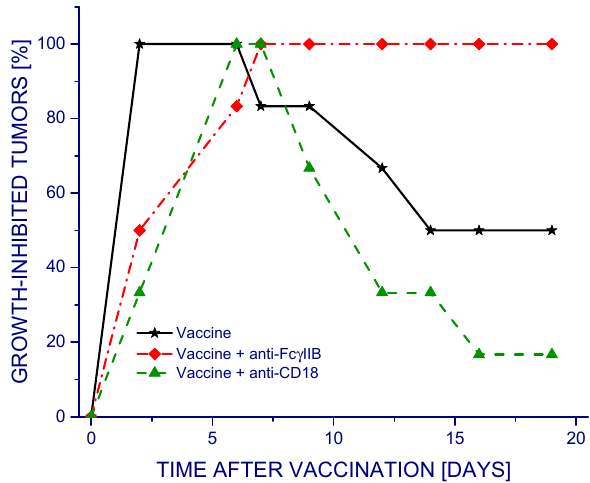
Figure 2. The effect of blocking complement CR3/CR4 receptors (CD18) or immune inhibitory receptor Fc γ RIIB on the therapeutic efficacy of PDT-generated vaccines. Mice bearing SCCVII tumors received a peritumoral injection of vaccine cells prepared as described in Figure 1. Antibodies blocking specific phagocytic receptors were injected into mice (30 µ g/mouse i.p.) 30 min before vaccine administration. The response to therapy is presented as explained in Figure 1. The response to both groups, PDT vaccine plus anti-CD18 (triangles), and PDT plus anti-Fc γ RIIB (rombs), is statistically different from the vaccine only (stars) group ( p < 0.05; n = 6). Table 1. The impact of blocking various phagocytic receptors on the efficacy of PDT cancer vaccines. Phagocytic Receptor Blocked